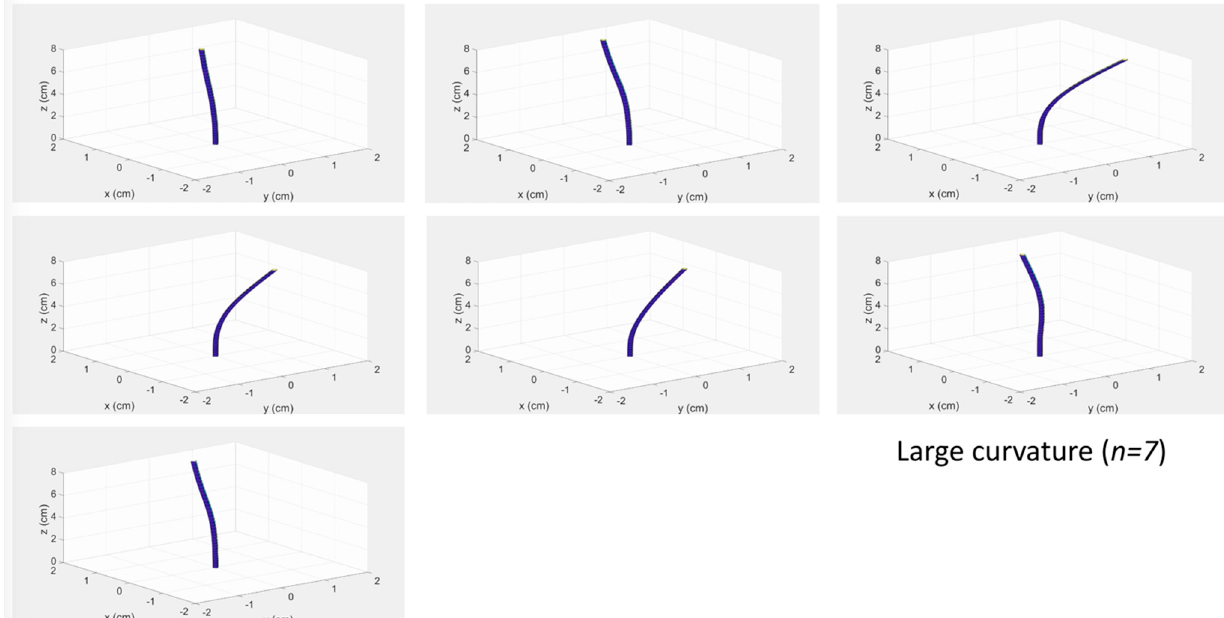
Figure 5. Screenshot of a video reconstructing the 3D shape of the epidural device through the penetration to the epidural space within the phantom. The videos for each experiment group are shown as Supplementary Materials.